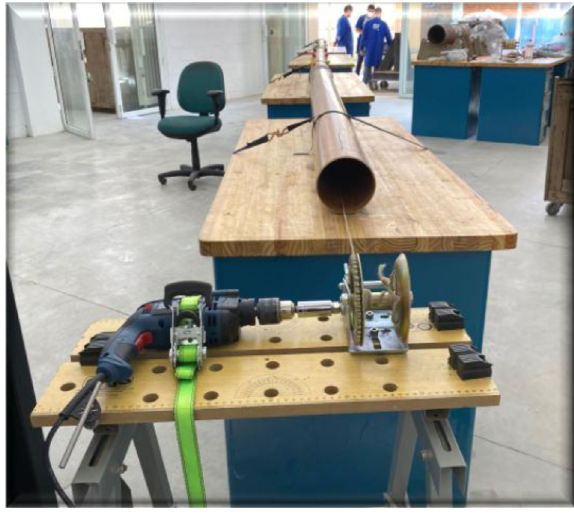
Fig. 8. Front view of the test bench.